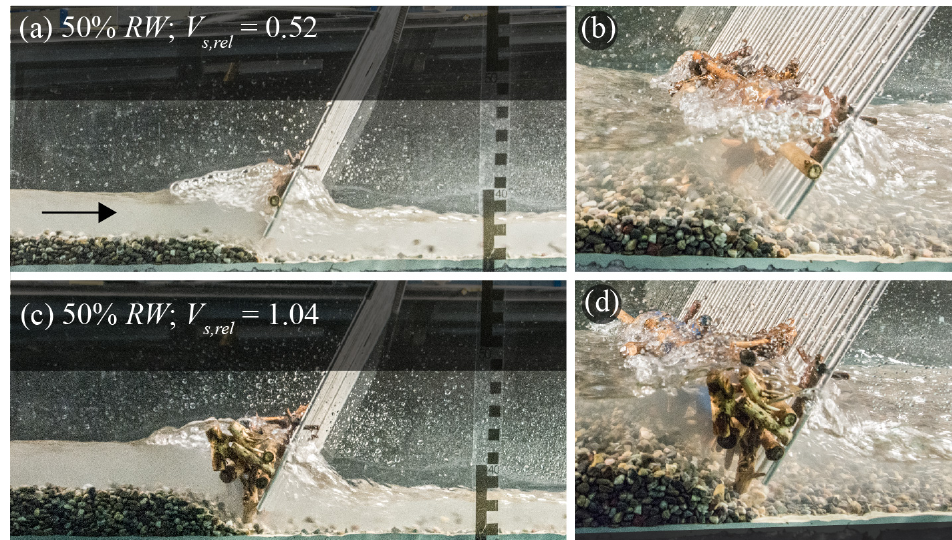
Figure 10. LW accumulation and bedload deposition at the inclined bar screen for test V14 with 50% RW and increasing V s , rel : ( a ) side view and ( b ) zoom with V s , rel = 0.52 and ( c ) side view and ( d ) zoom with V s , rel =